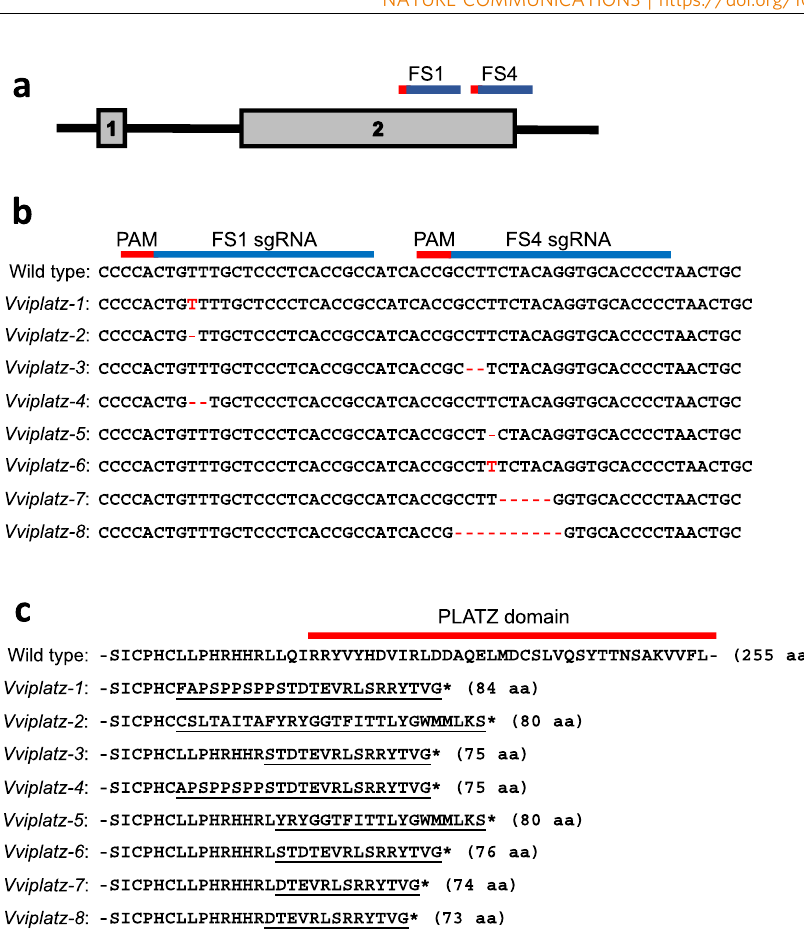
Fig. 3 Molecular characterization of CRISPR/Cas9 gene-edited VviPLATZ1 alleles. a Schematic illustration of the VviPLATZ1 genomic region targeted for CRISPR/Cas9 gene-editing. FS1 and FS4 guide RNAs were located at the 3 ′ end of exon two with FS4 traversing the exon two/intron two boundary. b Diagram of FS1 and FS4 guide RNA sequences aligned to VviPLATZ1 and the resulting indels and base pair changes induced by CRISPR/Cas9 for each allele. FS1 and FS4 guide RNAs highlighted in blue, while the protospacer adjacent motif (PAM) is shown in red. c Diagram displaying the effect that each CRISPR/Cas9 induced mutation had on the protein sequence upstream of the PLATZ domain (red bar). Note: only the N-terminal region of the PLATZ domain is shown. Frameshift mutations alter protein sequence (underlined) resulting in truncated proteins smaller than the full length 255 amino acid (aa)